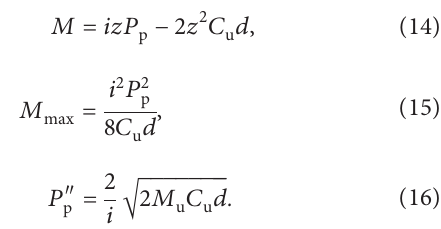
Figure 9: Stress on pile when